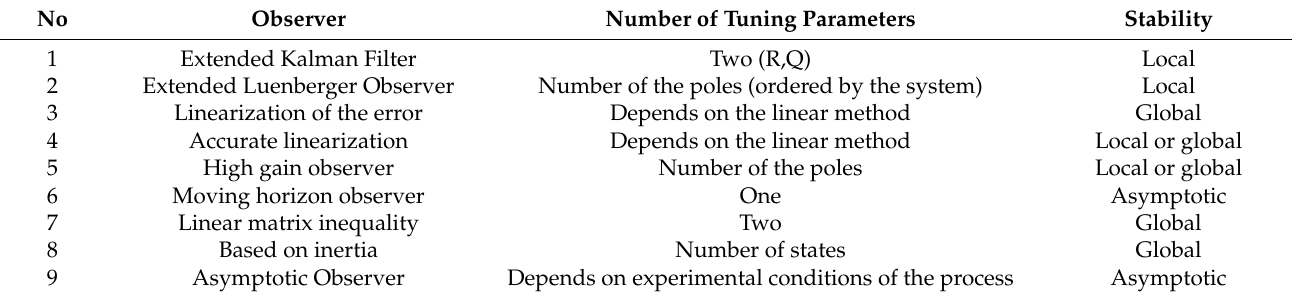
Table 2. Critical analysis of nonlinear